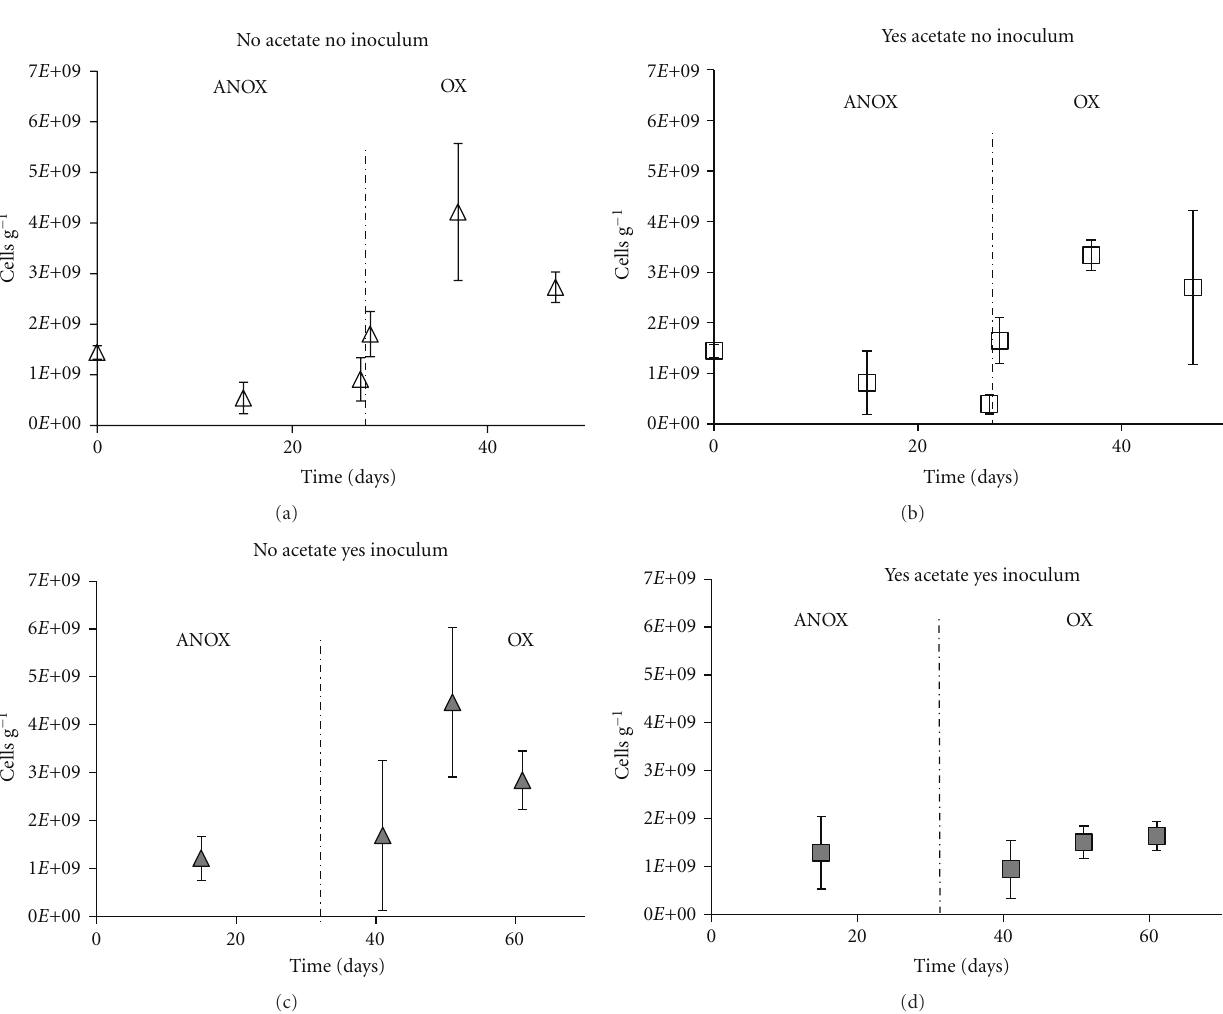
Figure 6: Microbial abundances in the two-step treatment (one month under anaerobic conditions). In each chart, the left part is referred to the anaerobic pretreatment (ANOX), and the right part to the aerobic treatment (OX). The operating conditions of the anaerobic pretreatment are specified in the